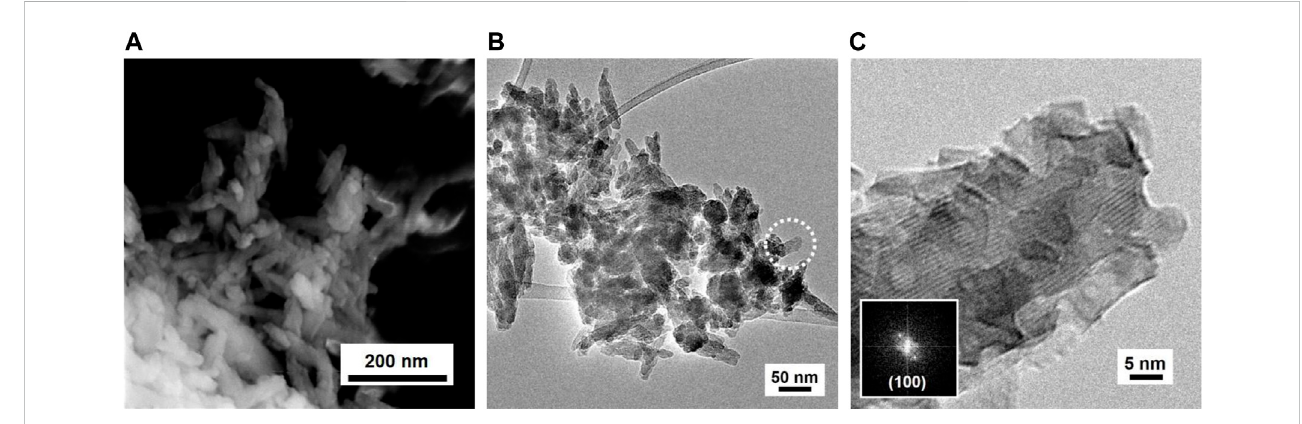
FIGURE 1 SEM (A) and TEM (B, C) images of the obtained HP NPs.